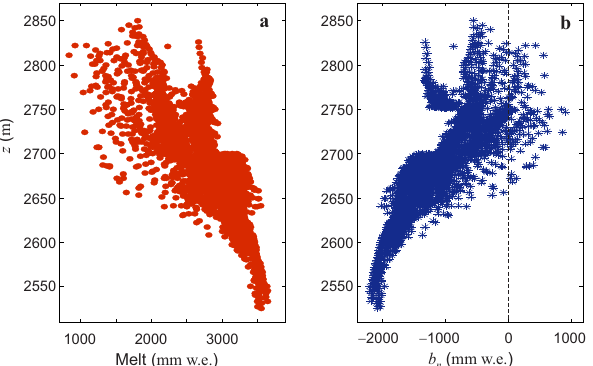
glacier outlet streams (Fountain and Tangborn, 1985). Peri- ods of high overnight flows reflect either rain events or warm nights when melting did not shut down on the glacier